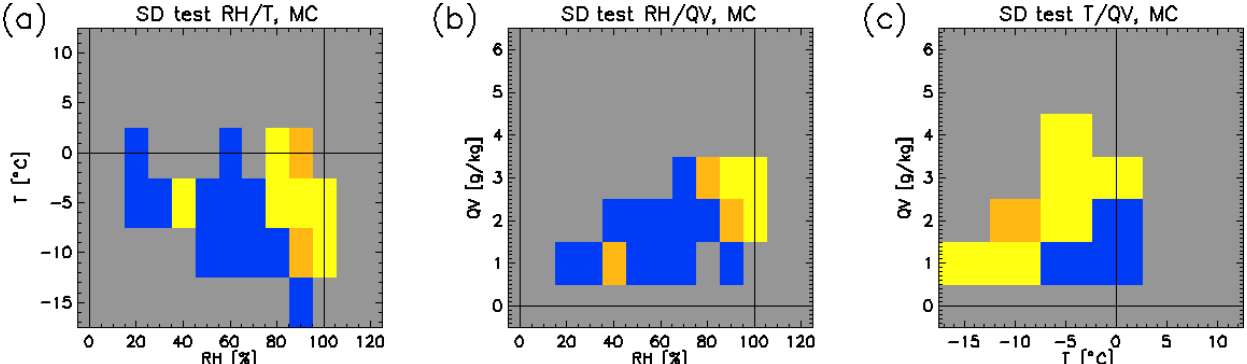
Figure 10. The closeness of the observed ARISE QC per thermodynamic regime to the simulated QC from the full ASR dataset. The metric is units of standard deviation; the standard deviations are taken from the random sampling results (Fig. 8d, h, and l). Yellow indicates regimes with a QC within 1 standard deviation; orange is 2, and blue is greater than 2. Gray indicates regimes lacking data from ARISE and/or ASR. Panel (a) shows regimes of temperature and relative humidity, (b) of relative humidity and specific humidity, and (c) of temperature and specific